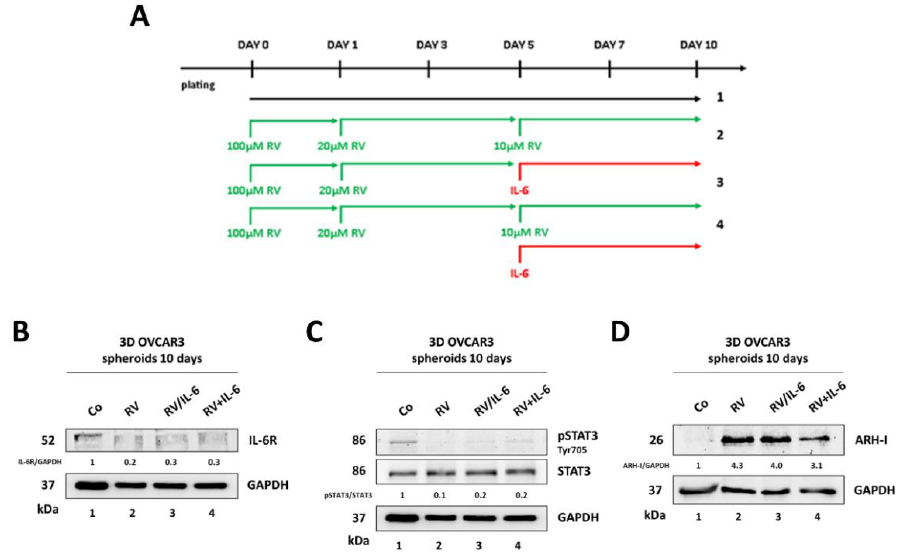
Figure 5. Resveratrol hampers IL-6R/STAT3 signaling in 3D ovarian cancer spheroids. ( A ) Experi- mental timeline of the 3D spheroids-forming assay. ( B – D ) Western blotting showing the expression of IL-6R ( B ), pSTAT3 (Tyr705)/STAT3 ( C ), and ARH-I ( D ) on day 10. The densitometric analysis of Western blotting representative of three replicates is included.